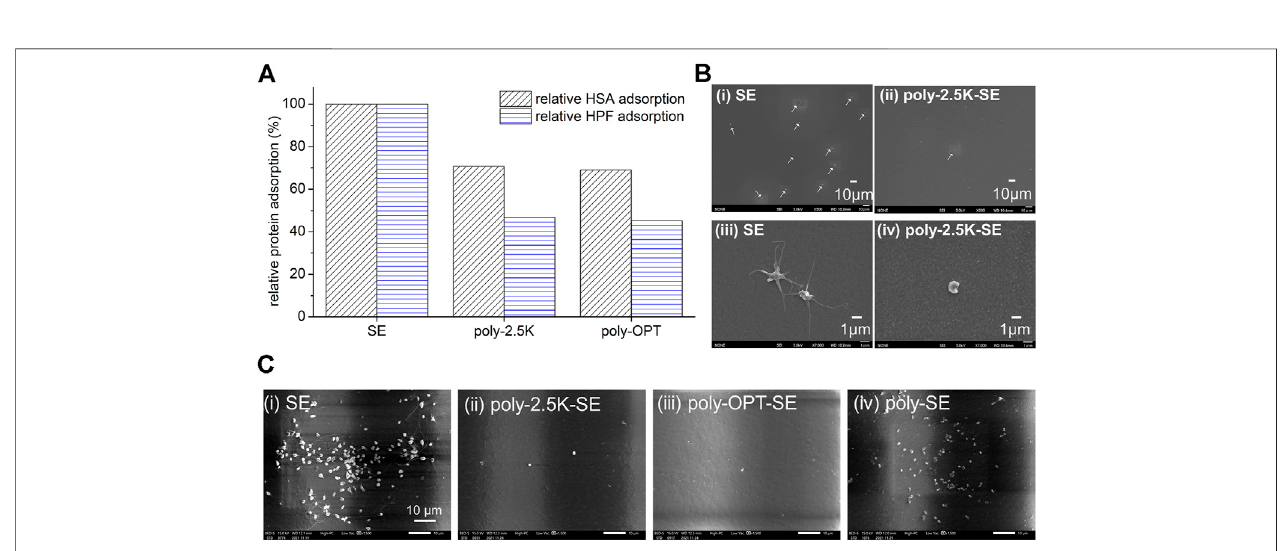
FIGURE 7 | (A) Relative HSA and HPF adsorption on the uncoated SE, poly-OPT-SE, as well as the poly-2.5K-SE via µ-BCA assay. (B) Hemocompatibility evaluationunderstaticcondition.SEMmicrographsofSEandpoly-2.5K-SEafterincubationinPRPfor1 hat37 ° C,(i)-(ii)magni fi edimage(500X),(iii)-(iv)magni fi edimage (7,000X). (C) Hemocompatibilityevaluationafteragingunder fl uidiccirculationfor4weeks.SEMmicrographsof(i)SE,(ii)poly-2.5K-SE,(iii)poly-OPT-SE,and(iv)poly-SE after incubation in PRP for 1 h at 37 ° C.